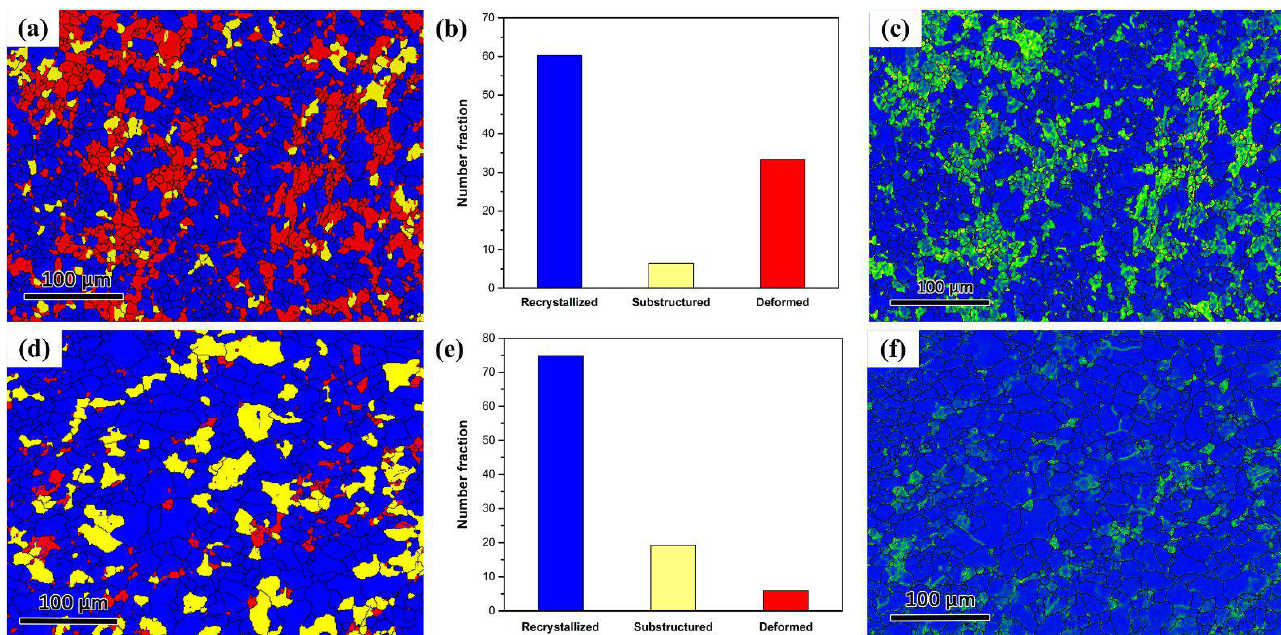
Figure 4. Recrystallized, substructured and deformed fraction as well as the KAM map of the CI and CA samples: ( a – c ) the CI sample; ( d – f ) the CA sample.